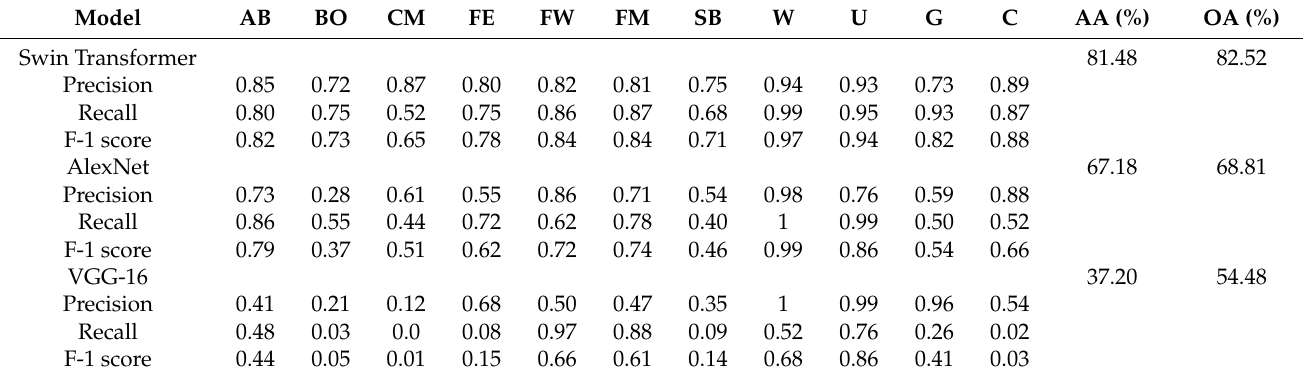
Table 3. Results of the proposed multi-model compared to other classifiers in terms of average accuracy, precision, F1-score, and recall (AB = Aquatic bed, BO = Bog, CM = Coastal marsh, FE = Fen, FM = Freshwater marsh, FW = Forested wetland, SB = Shrub wetland, W = Water, U = Urban, G = Grass, C = Crop, AA = Average accuracy, OA = Overall